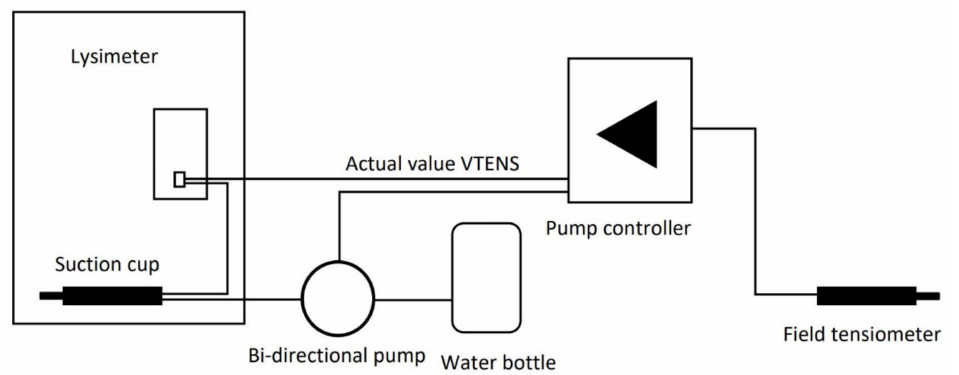
Figure 2. Schematic chart of how the smart field lysimeter operates (created after UMS GmbH